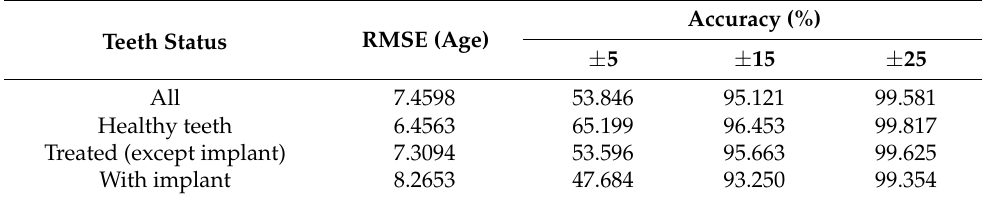
Table 2. Root mean square errors and accuracies according to teeth